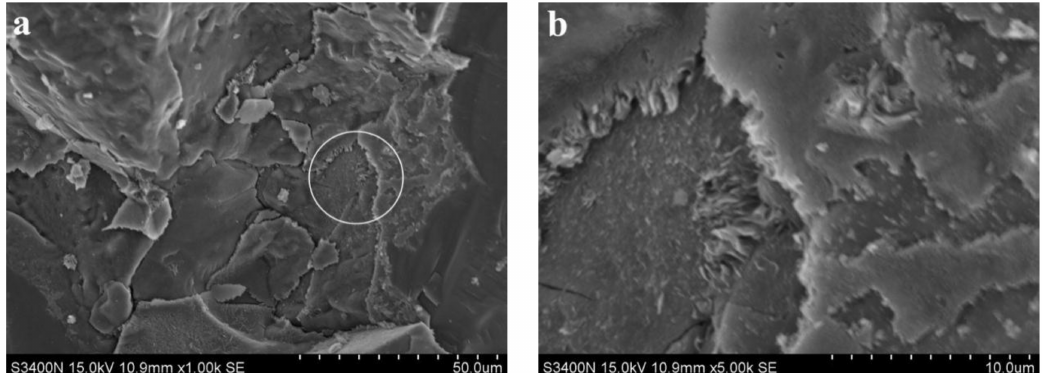
Figure 8. SEM images of alkali slag cement mortar with hydration ages of 3 d. ( a ) × 1.00 k, ( b ) × 5.00 k.